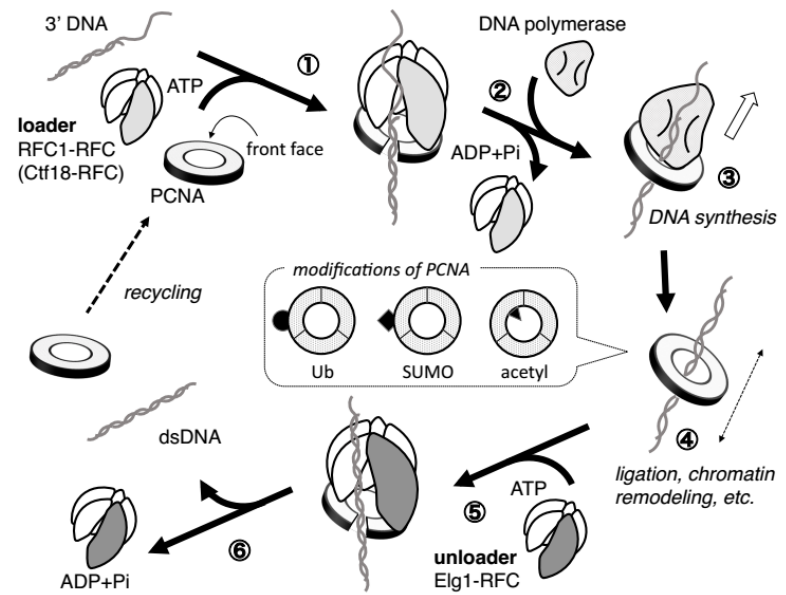
Figure 2. PCNA loading on and unloading from chromatin by RFC complexes during DNA synthesis. ① PCNA loader RFC1 ‐ RFC or Ctf18 ‐ RFC bind to PCNA and recognize the 3 ′ DNA